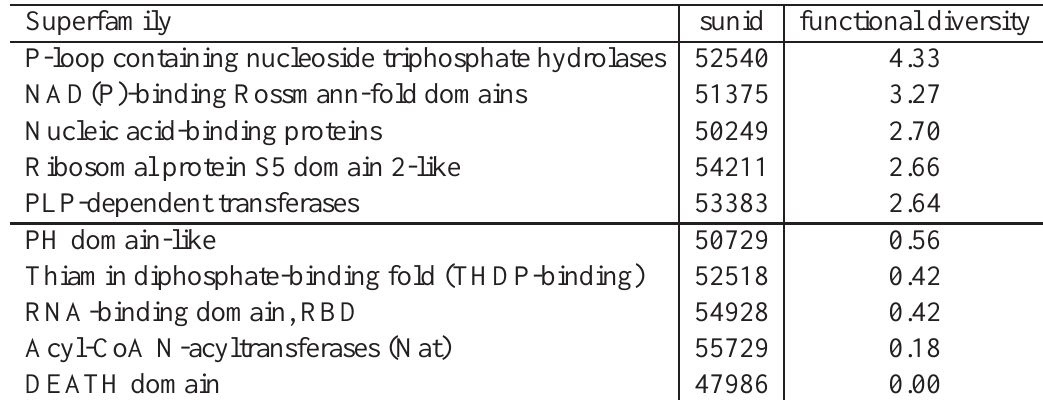
Table 1: Most and least diverse superfamilies in the dataset using a depth weighting of